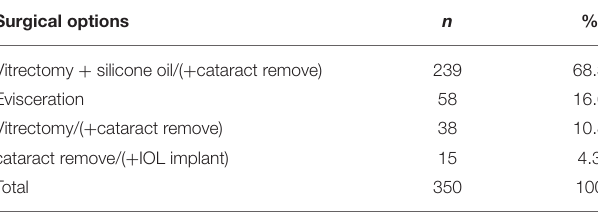
TABLE 3 | Secondary intervention.